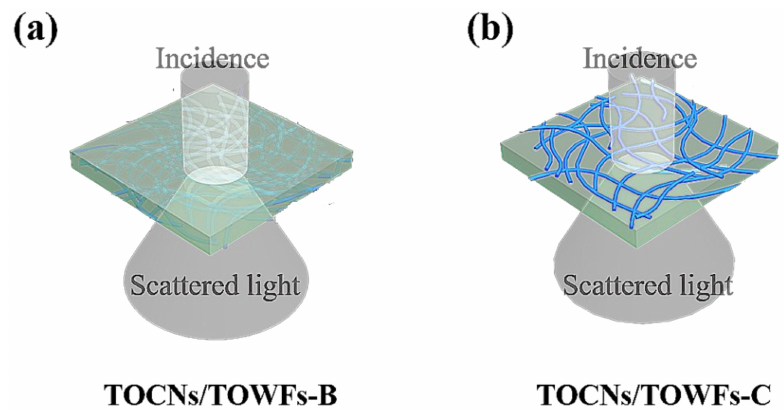
Figure 3. Mechanism of light scattering of ( a ) TOCNs/TOWFs-B films and ( b ) TOCNs/TOWFs-C